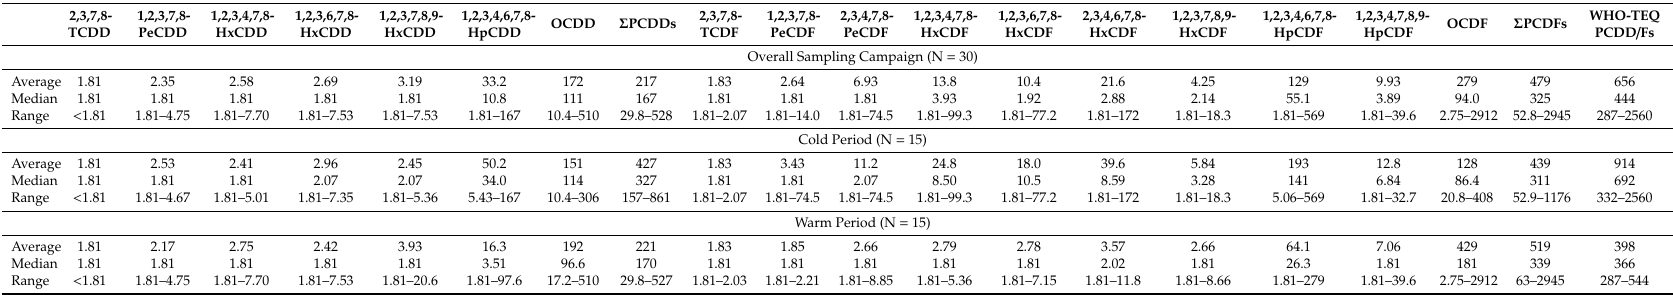
Table 3. Average, median, and ranged concentrations of polychlorinated dibenzo-p-dioxins / dibenzofurans (PCDD / Fs) (fg m − 3 ) for the overall and seasonally divided sampling period.